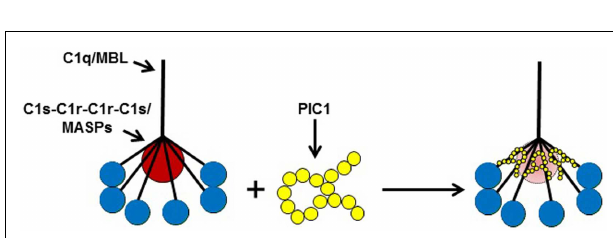
FIGURE 3 |A model of PIC1 interfering with the normal association of C1q/MBL with their cognate serine proteases (C1s–C1r–C1r–C1s/ MASPs) . Our data suggest PIC1 functionally disrupts the C1s–C1r–C1r– C1s/MASPs interaction with collagen-like region (CLR) of C1q/MBL, respectively. By virtue of PIC1 binding to this region of the CLR, the serine proteases are hypothesized to be in suboptimal conformation for autoactivation and initiation of the classical and/or lectin pathways of